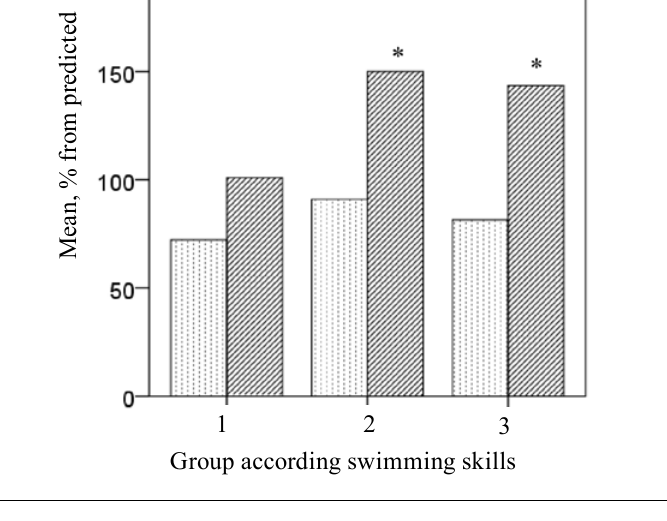
Figure 1. Mean maximal expiratory (MEP) and inspiratory (MIP) pressures in per cent from the predicted value in the room for students with different swimming skills